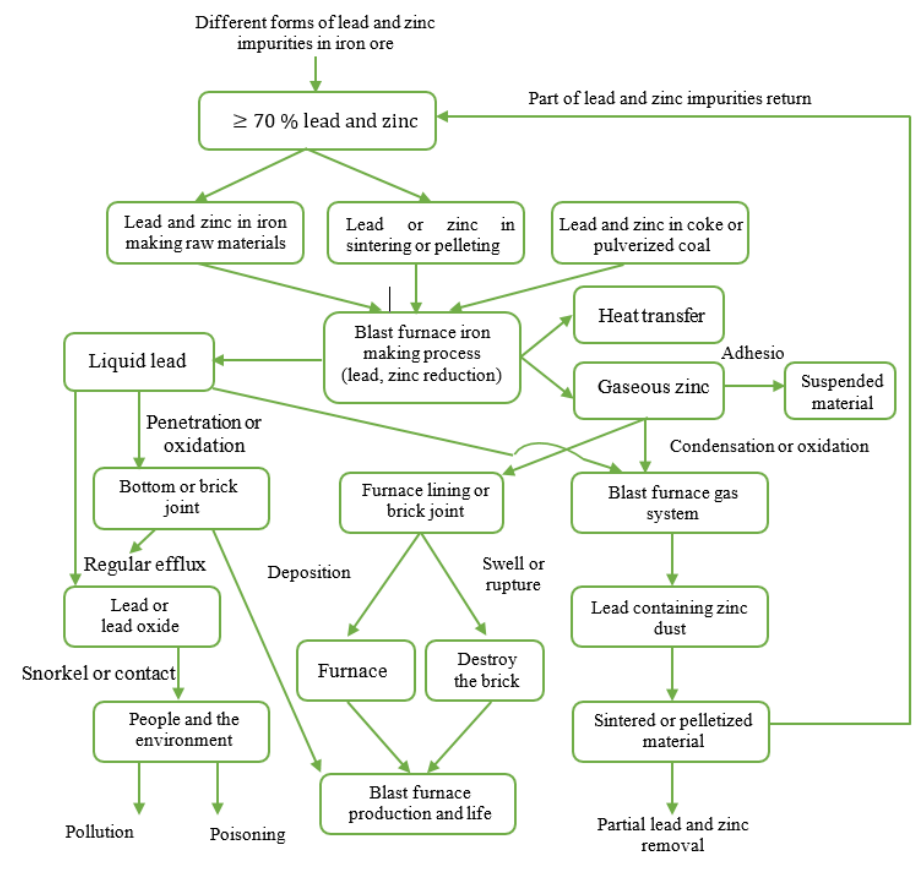
Figure 5. Source, impact, and cycle route diagram of Pb and Zn.